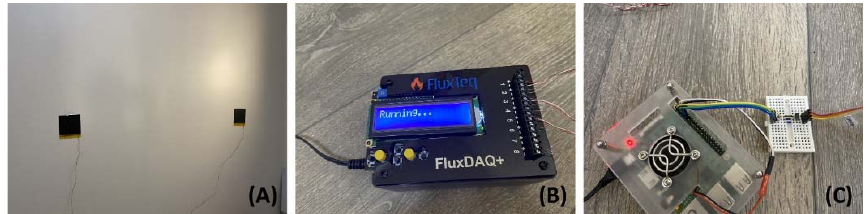
Figure 3. The equipment used for monitoring the buildings. ( A ) Heat flux meter (PHFS ‐ 09e heat flux and surface temperature sensor). ( B ) The data logger (FluxDAQ+ data logging system developed by Fluxteq). ( C ) Internal and external temperature monitoring (custom made Raspberry Pi for data logging with one wire calibrated air temperature sensors (DS18B20)).